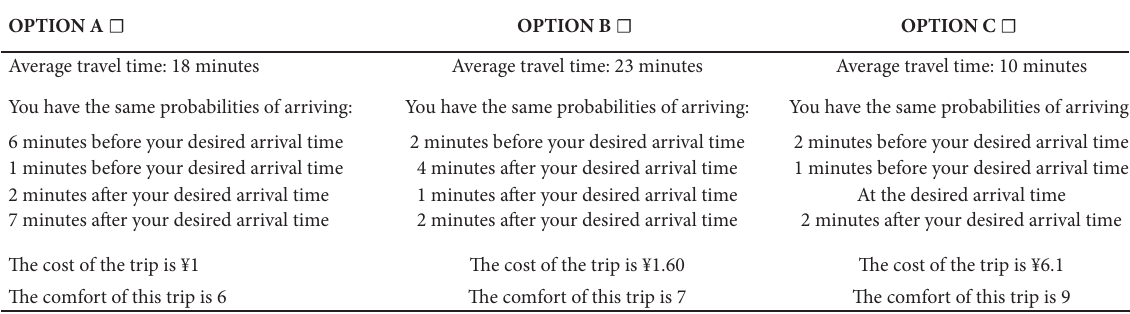
Figure 1: Example of choice presented for one scenario (option (A) bus; option (B) metro; and option (C) car). Table 1: Sample characteristics: occupation and income.